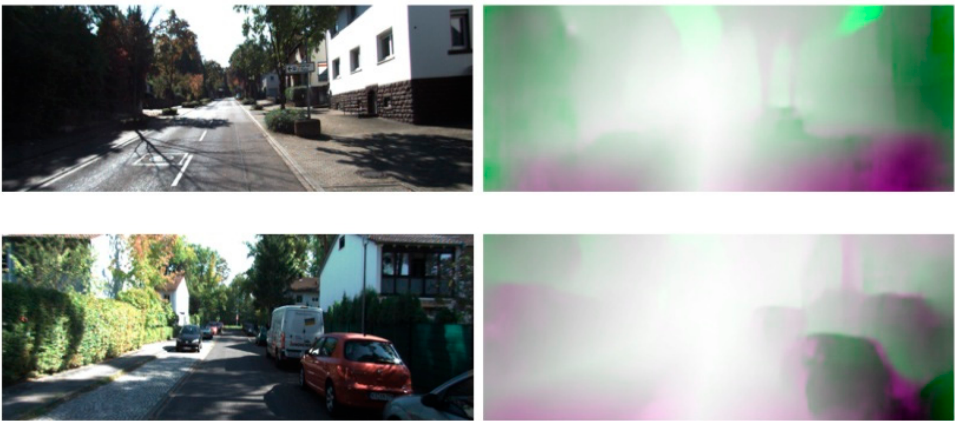
Figure 3. Flow local consistency check result. The left column scenes are the input color data, and the right column represents the local consistency results. The outside of each local consistency scene has more errors than the center of the result owing to scene variation.